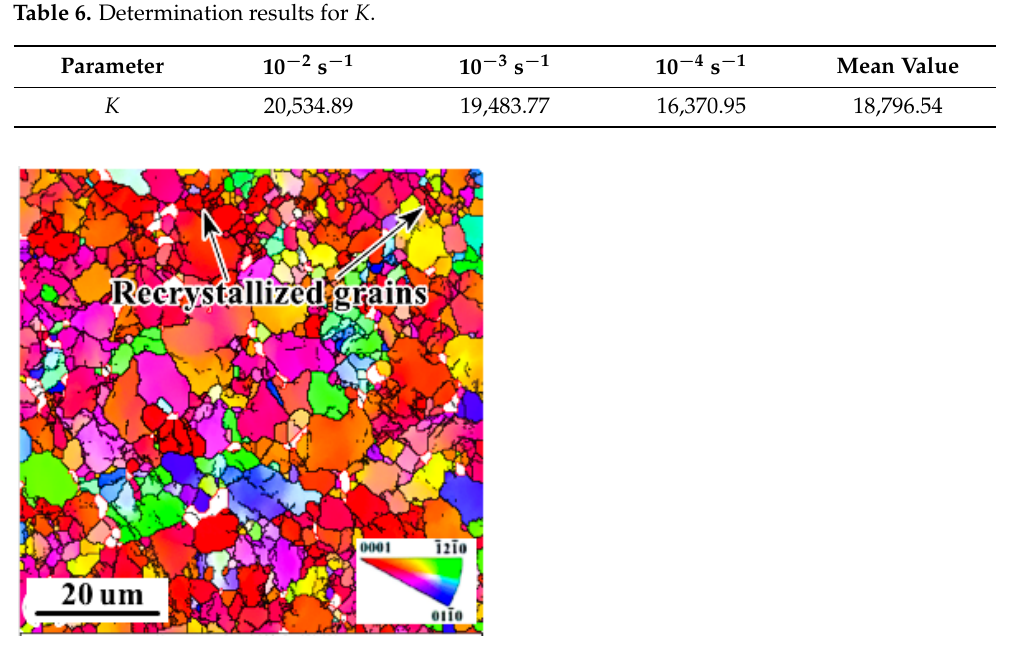
Figure 9. Dynamic recrystallization during air cooling deformation as measured by EBSD at 700 °C and 10 − 4 /s.